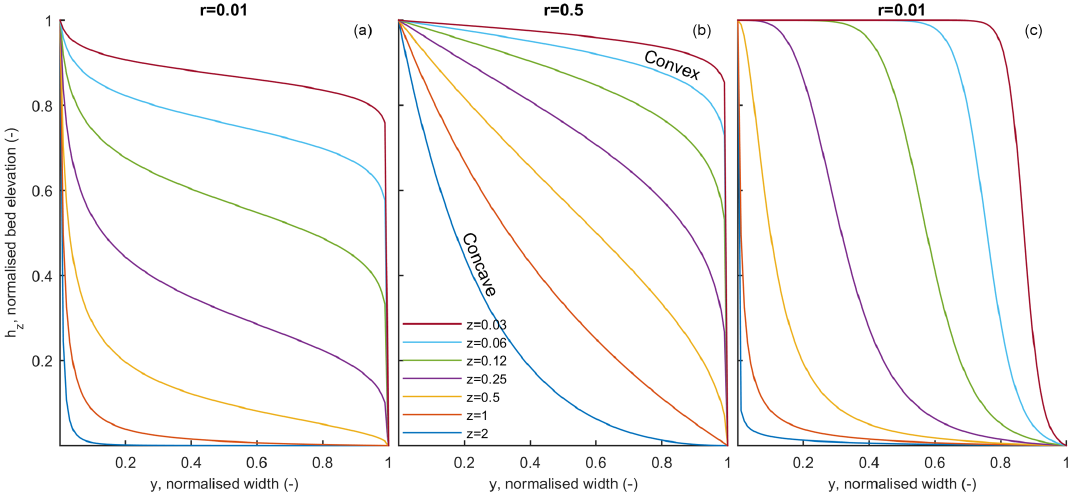
Figure 2. Hypsometric functions to describe morphological systems; modified from Strahler (1952). (a, b) Effect of z values with the r value kept constant. (c) Inverted version of the Strahler function (see Eq. 4).